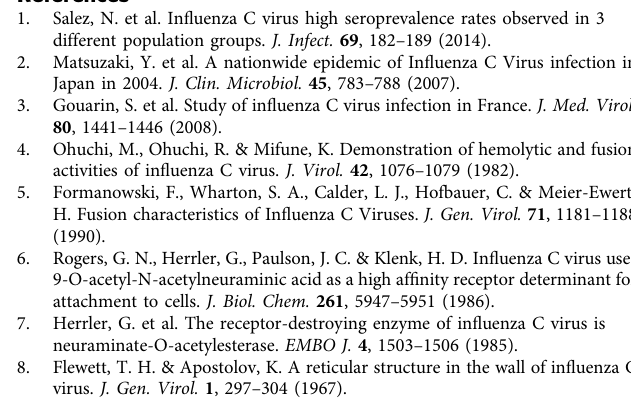
Table 1. Cryomicrographs for helical reconstruction were collected on a Tecnai Spirit transmission electron microscope (TEM, FEI) operated at 120 keV and equipped with an Eagle 4k detector (FEI) at a pixel size of 3.6 Å/pixel. Tilt series for tomographic reconstruction and subtomogram averaging were collected on a Titan Krios TEM (Thermo Fisher) using the Tomography software (Thermo Fisher) for automation. The microscope was fi tted with a Gatan GIF Quantum energy fi lter operating in zero-loss mode with a slit width of 20eV and a K2 Summit direct electron detector (Gatan) operated in counting mode. Bi-directional tomographic tilt series were collected from 0° to + 54° and − 3° to − 54° (or − 42°) at a 3° interval in movie mode at a pixel size of 2.2Å/pixel. Four frames were collected per tilt with a dose of 1.57e − /Å 2 per tilt, giving a total accumulated dose of 58.1 e − /Å 2 (or 51.8e − /Å 2 ) for each tilt series. Movie frames were motion-corrected and dose weighted using alignframes from the IMOD package 27,28 . Tilt series were aligned using Etomo from the IMOD package 27,28 , the contrast transfer function (CTF) was estimated using CTFFIND4 29 and tomograms were CTF corrected and reconstructed using novaCTF 30 . Helical reconstruction . A single fi lamentous virion was imaged at three different defoci on a Technai Spirit TEM (see above). Iterative helical reconstruction 31 was performed using SPIDER 32 where parameters for the helical rise (42.12 Å), turn ( − 18.53°), and symmetry (C7) were obtained. Further helical processing 33